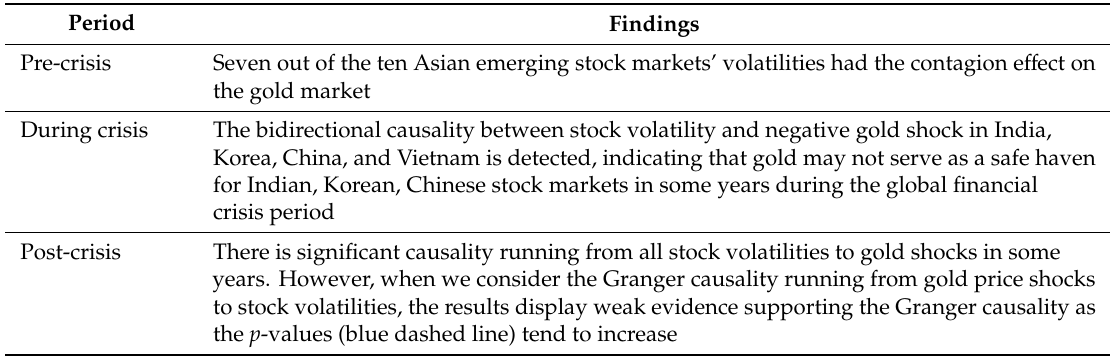
Table 6. Summary results of rolling window Granger causality in three periods.